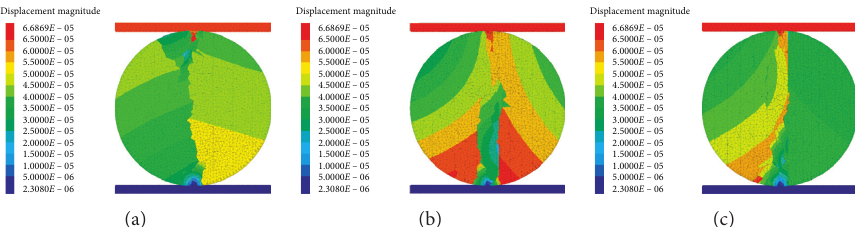
Figure 18: Cloud diagrams of loading and displacement of parallel bedding model with uneven layer thickness. (a) 2 and 6. (b) 6 and 12. (c) 10 and 18.